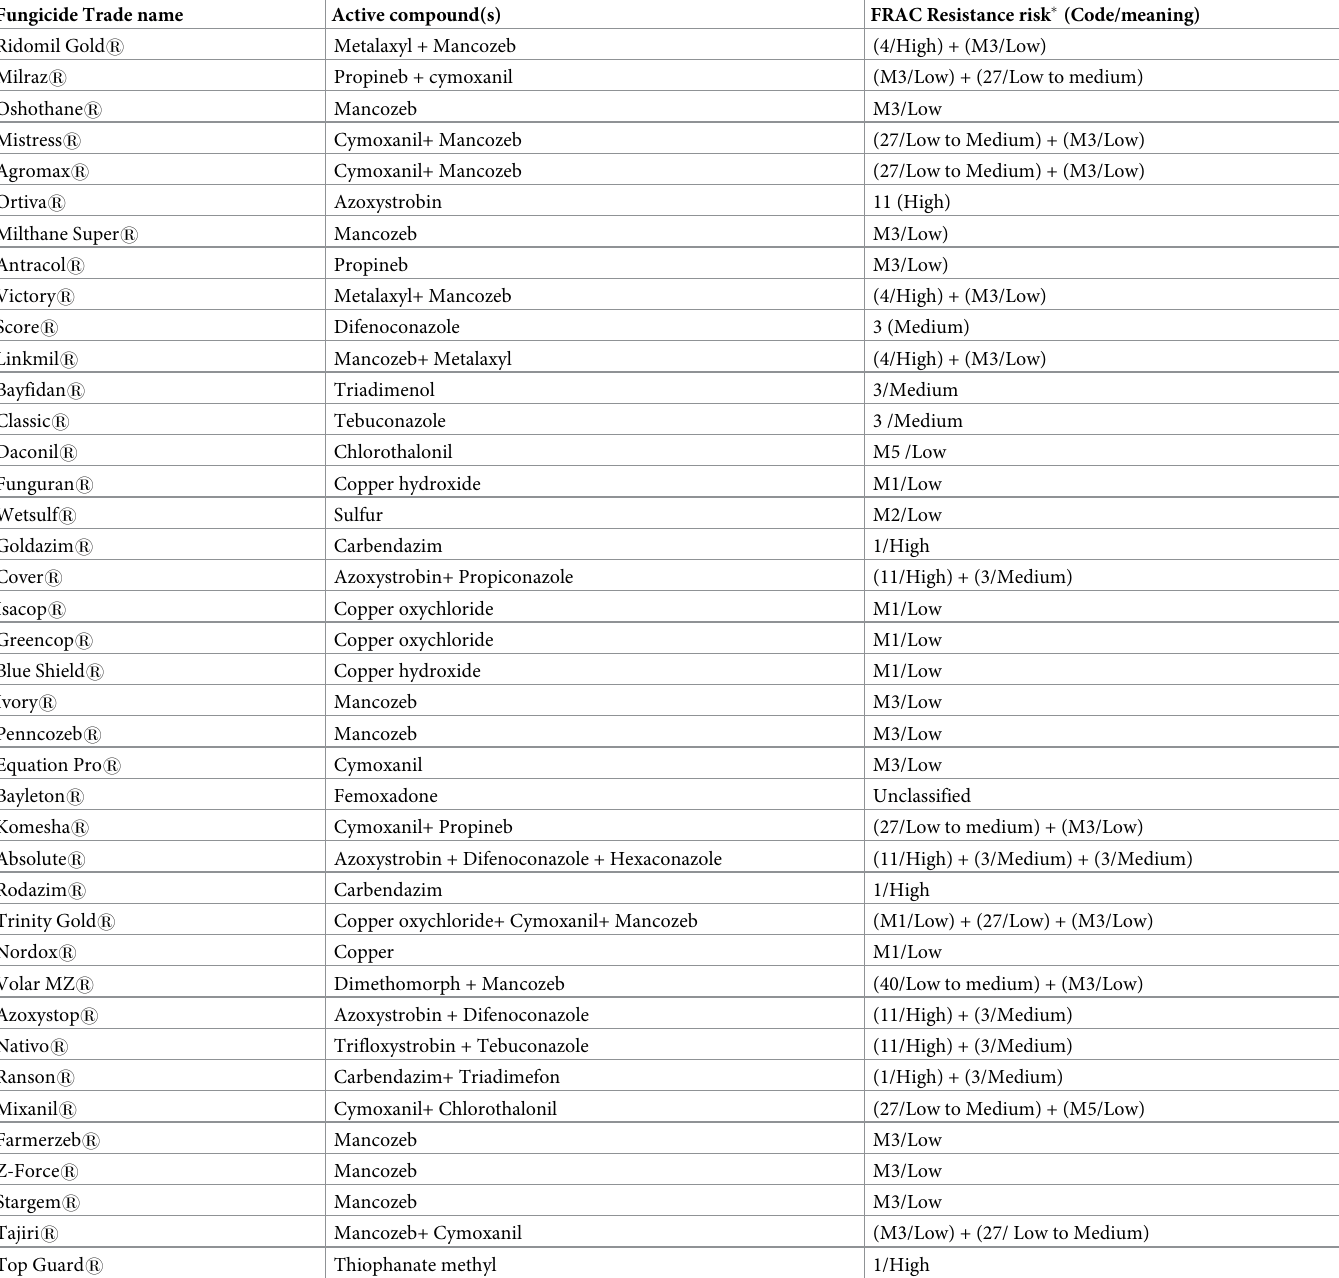
Table 4. Active ingredients in fungicide products used to control tomato early blight and their FRAC resistance risk codes. Fungicide Trade